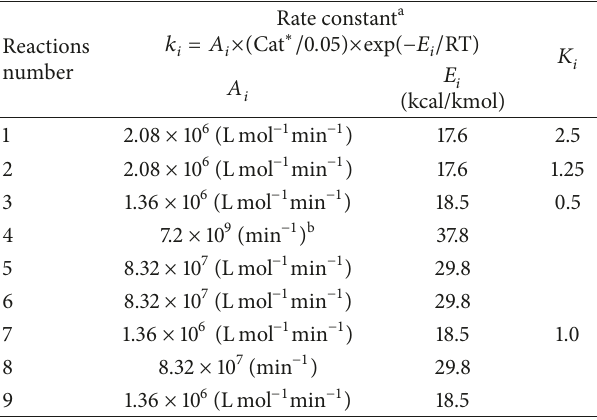
Table 2: Kinetic rate constants [27, 34,